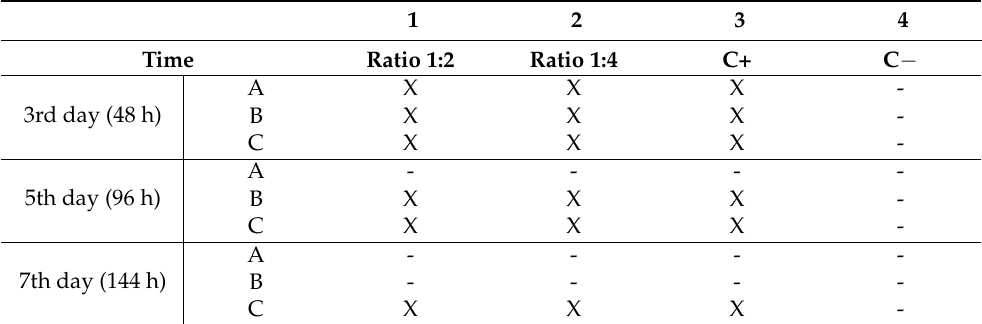
Table 1. Preparation of 24-well plates. The numbers 1, 2, 3, and 4 are the columns in plates, and A, B, and C are the rows in the plate. Cells were fixed on the ninth day. X denotes a treatment, (-) denotes only a change in